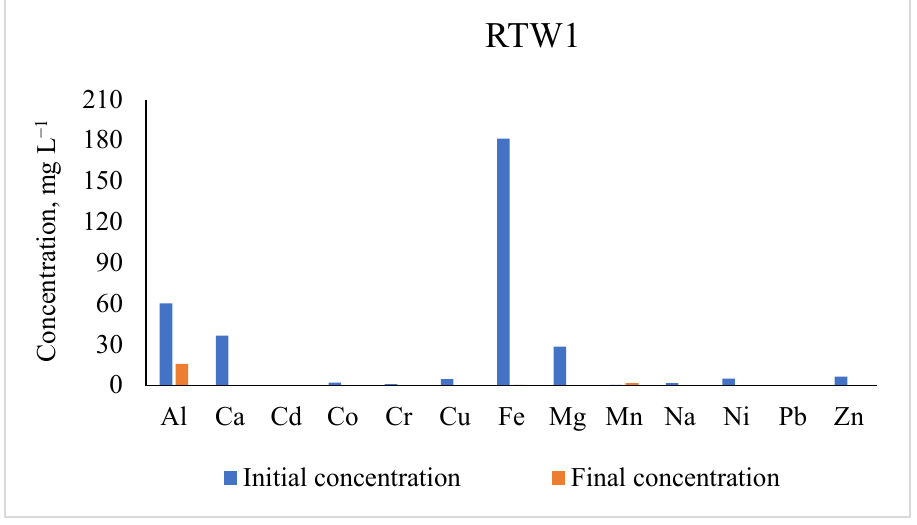
Figure 7. Initial and residual concentrations of metals in water samples collected from RTW1. The AMD sample also contained a high concentration of Cd, which was greater than SANS 241-2015 for drinking water ( ≤ 3 µ g L − 1 ) (Table 3). Therefore, the removal of all metals from AMD by Na 2 FeO 4 ranged between 26 and 100%. The low percentage removal TDS greater than 1000 mg L − 1 . The previous study on Cd removal from natural water values